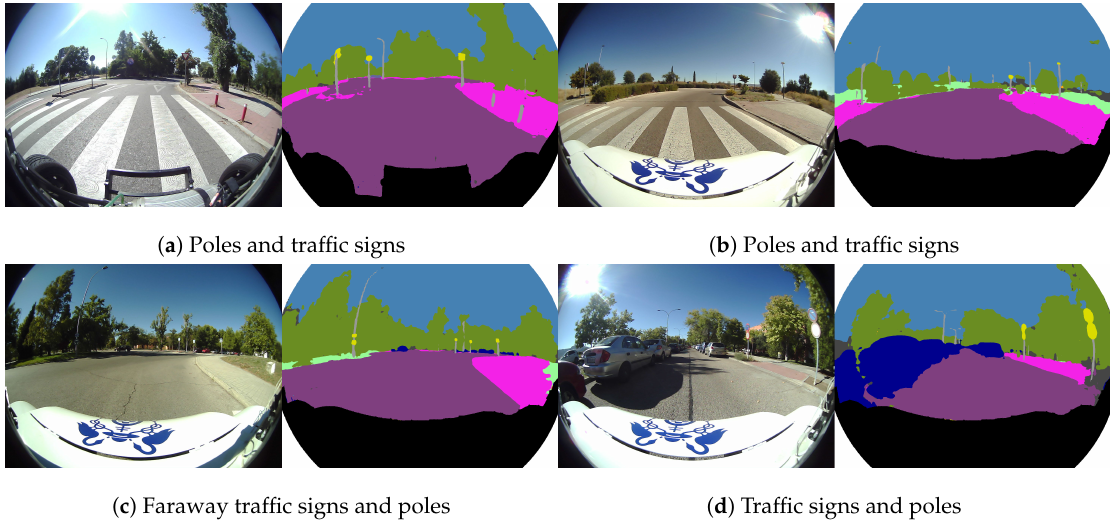
Figure 17. Real fisheye camera semantic segmentation examples for the object group.